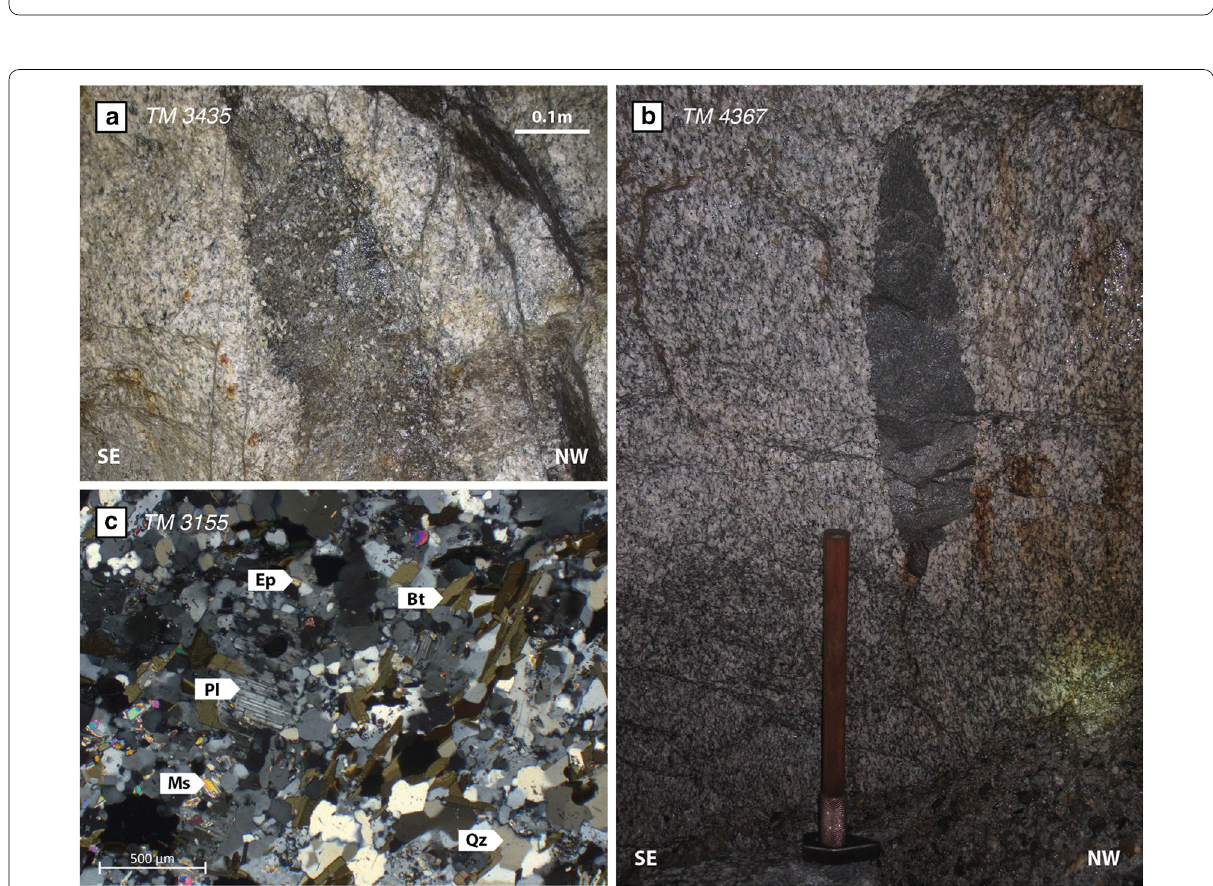
Fig. 9 a Enclave within the Rotondo granite (RG1) showing indications of magma mingling and therefore interpreted as a magmatic enclave. b Enclave in the Rotondo granite with sharp contact interpreted as xenolith, hammer for scale. c Thin section cutout of an enclave with sharp contact to the granite, which is interpreted as a xenolith (crossed polarized